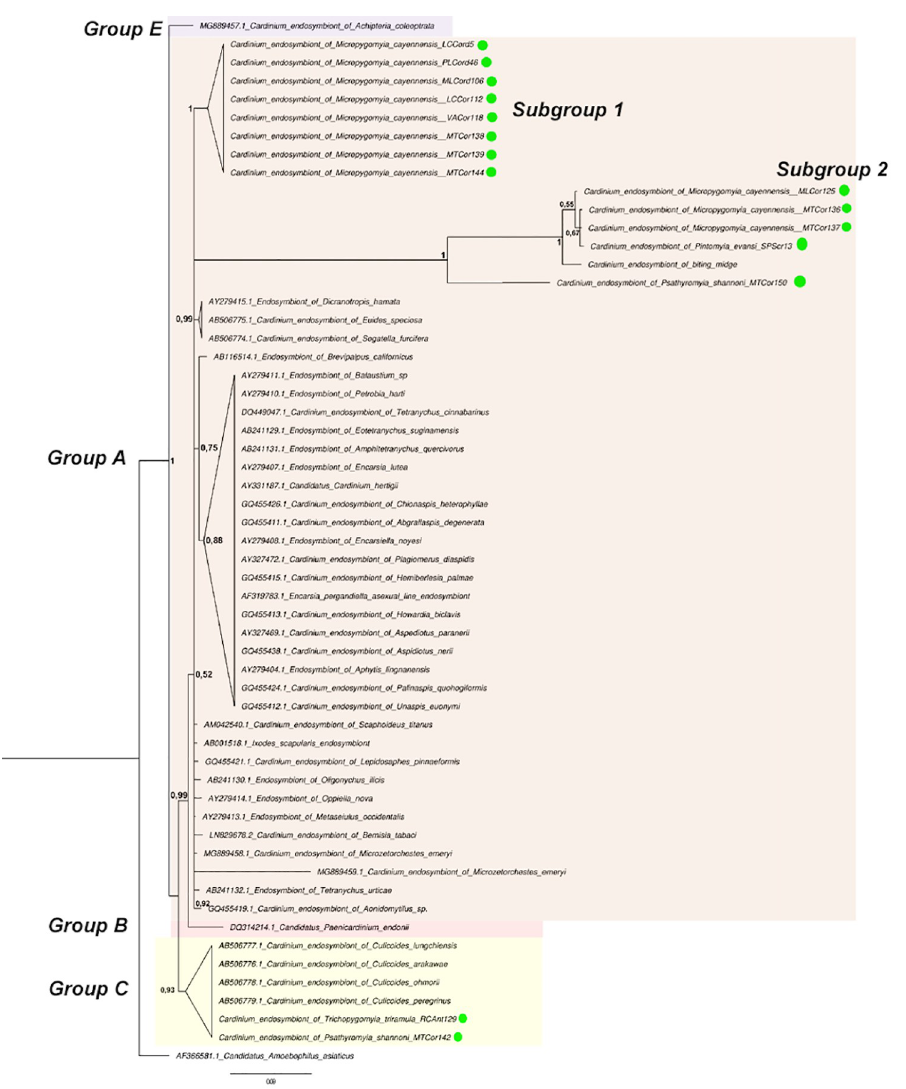
Fig 4. Phylogenetic relationships of Cardinium strains using Bayesian analysis and based on 16S rDNA sequences. The Cardinium strains are identified by host species from which they were isolated (sand flies symbol of green color). Numbers in nodes represent Bayesian posterior probabilities. The reconstruction was performed using MrBayes (version 3.0). As an outgroup was used Candidatus Amoebophilus asiaticus . Taxa without GenBank accession numbers are original for this data